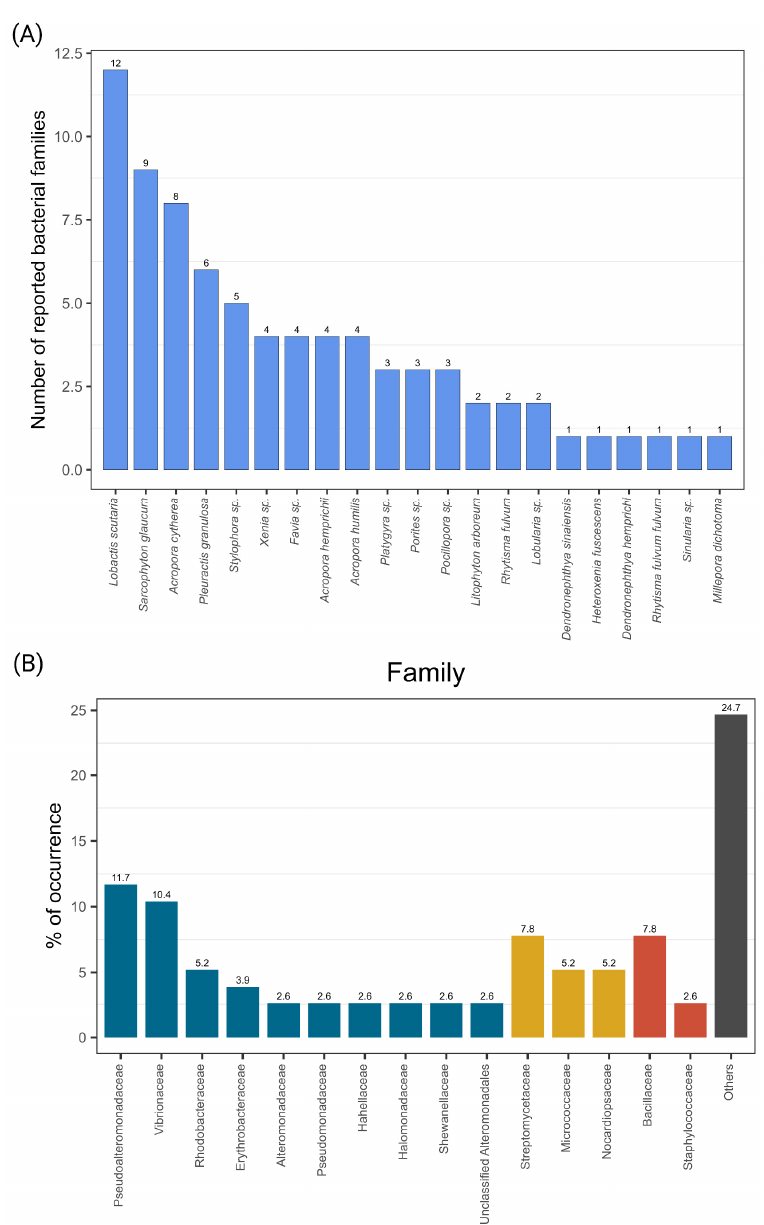
Figure 6. Coral-associated bacteria based on the examined culture-dependent studies. ( A ) Number of reported bacterial families associated with different coral species. ( B ) Frequency of bacterial diversity at the family level. Bacterial families are color-coded per phylum following Figure 2. Families with a lower frequency were grouped under “Others”.